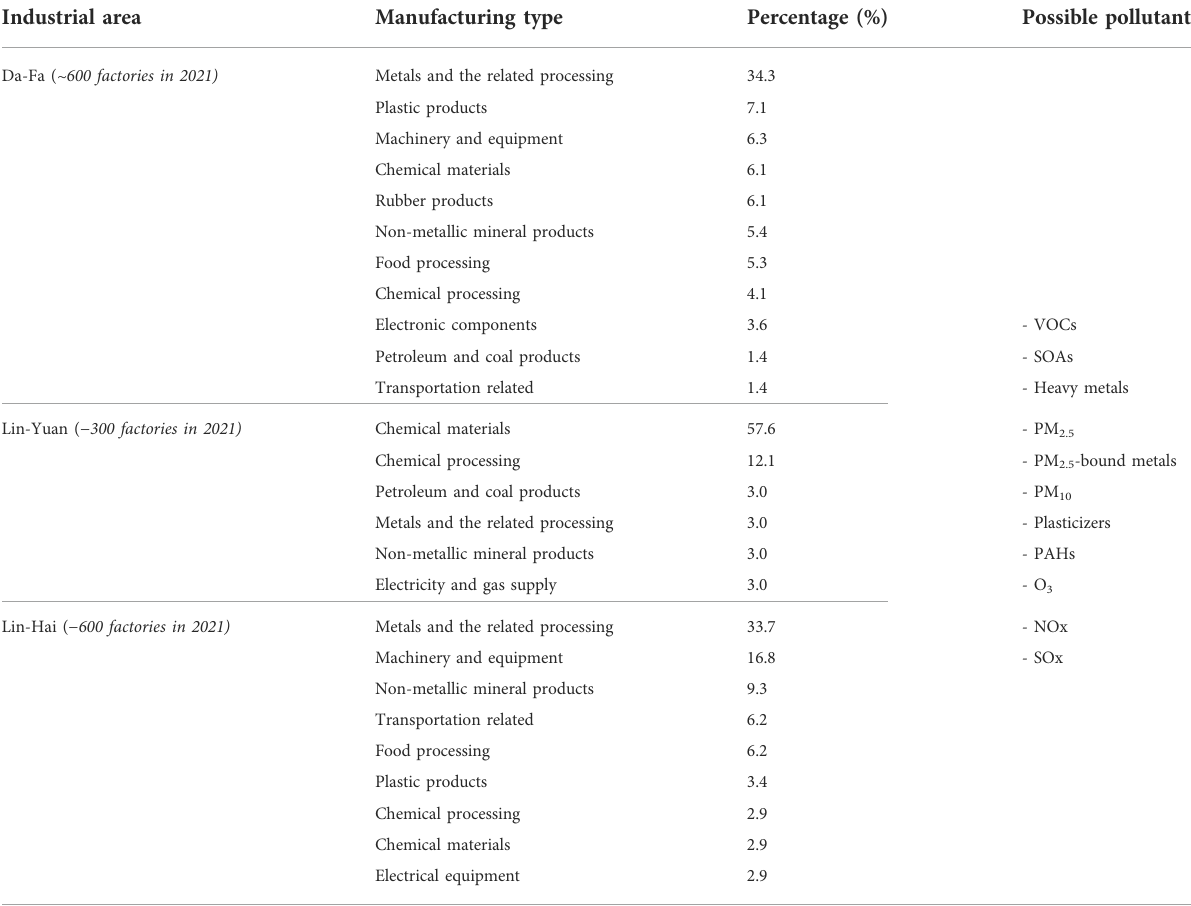
TABLE 1 Summary of the top 80% of manufacturing types in three major industrial areas of southern Kaohsiung city and some possible